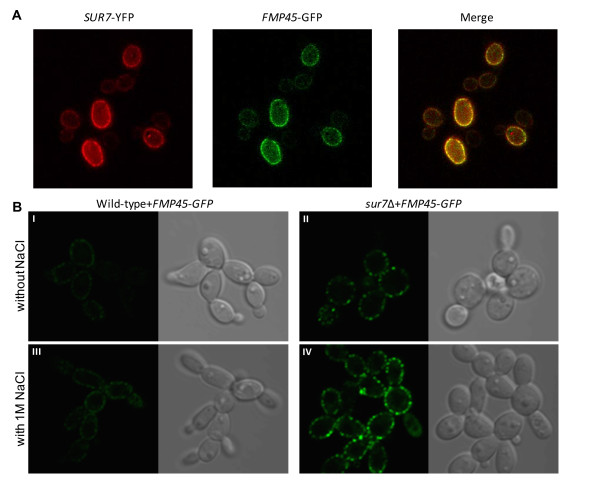
Induction and cellular localization of Fmp45p-GFP. (A) Spectral cube (fluorescence) images were acquired using the Nuance™ Multispectral Imaging System (CRi) to assess cellular localization of Fmp45p-GFP and Sur7p-YFP in the multi-labelled strain SUR7-YFP FMP45-GFP. Individual localization is shown for each protein of interest (Sur7p-YFP and Fmp45p-GFP). Sur7p-YFP was artificially rendered in red so that co-localized proteins can be readily distinguished (yellow) in the merged image. (B) Localization of Fmp45p-GFP in either the wild-type (BWP17) or sur7Δ null (SMB3) background was visualized by laser scanning confocal microscopy. Strains were grown at 42°C at a starting OD600 of 0.1 in complete synthetic medium, supplemented with 1.0 M NaCl where required. After 24 h growth, confocal fluorescence images were documented using parameters optimized for imaging the sur7Δ FMP45-GFP strain (sΔ-FMP45gfp) grown in the presence of high salt. Panels show fluorescence and DIC images of strains B-FMP45gfp (I and III, excluding and including salt, respectively) and sΔ-FMP45gfp (II and IV, excluding and including salt, respectively).